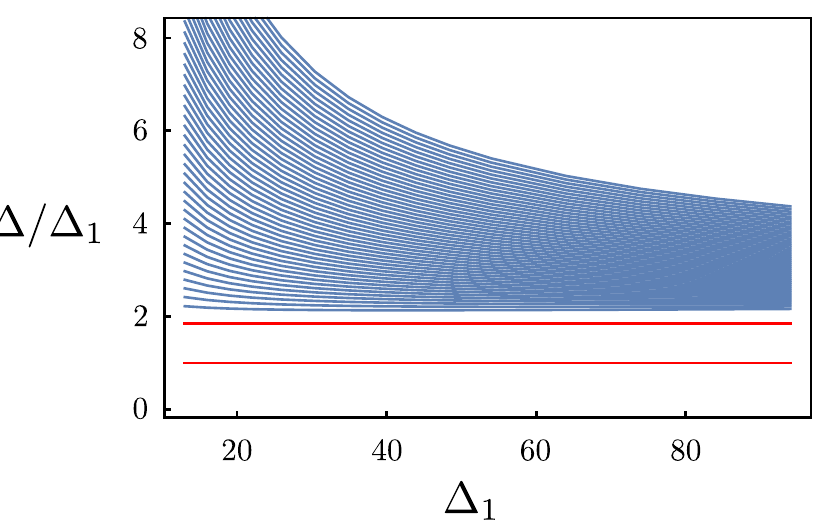
Figure 10 . Spectrum of operator dimensions of the solution to crossing symmetry that saturates the N = 300 bound for (cid:1) b = (cid:1) 1 = 1 : 85, as a function of (cid:1) 1 . As (cid:1) 1 increases the spectrum includes two bound states and a \two-particle continuum" starting at roughly 2(cid:1) 1